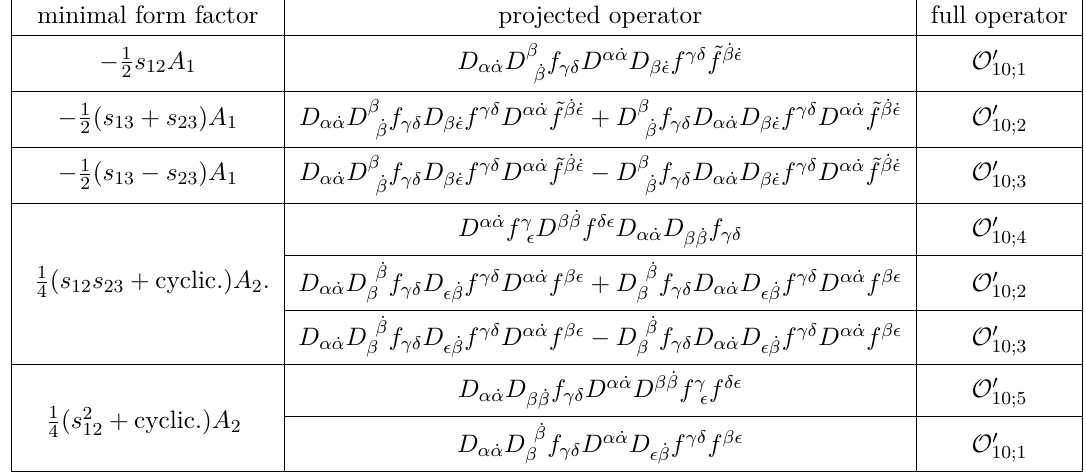
Table 4 . Operator-form factor dictionary of basis operators at dimension